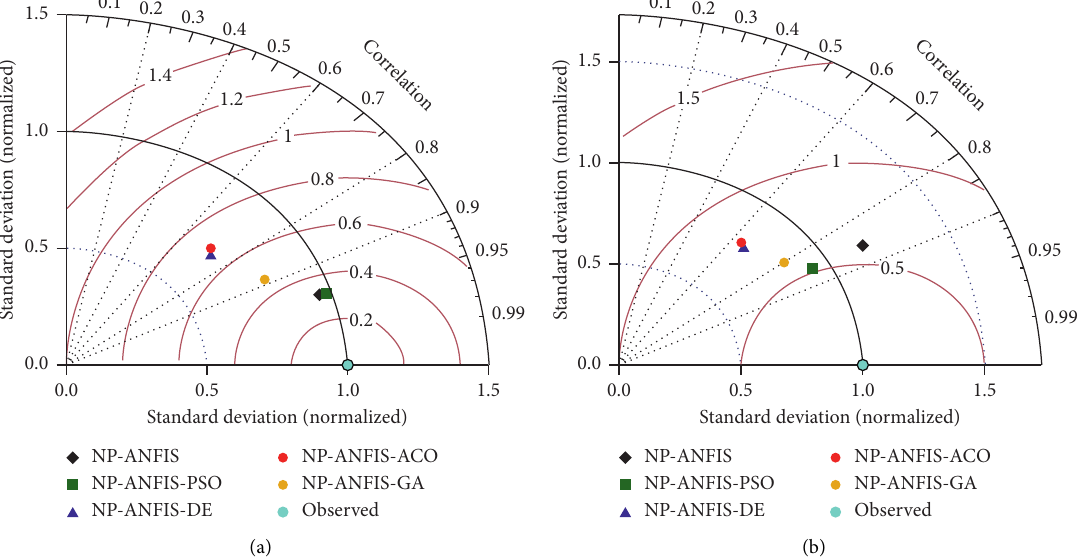
Figure 8: Normalized Taylor diagrams of predicted and observed shallow foundation settlement for the nonprocessed scenario: (a) training phase and (b) testing